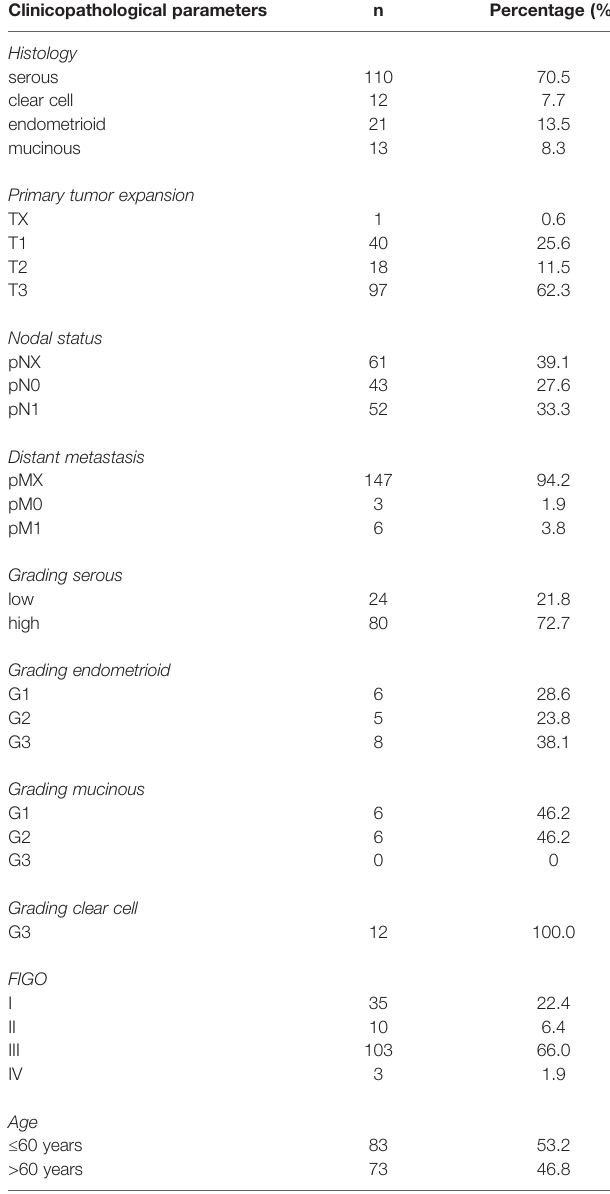
TABLE 1 | Clinicopathological characteristics of ovarian cancer patients considered in this study. Clinicopathological